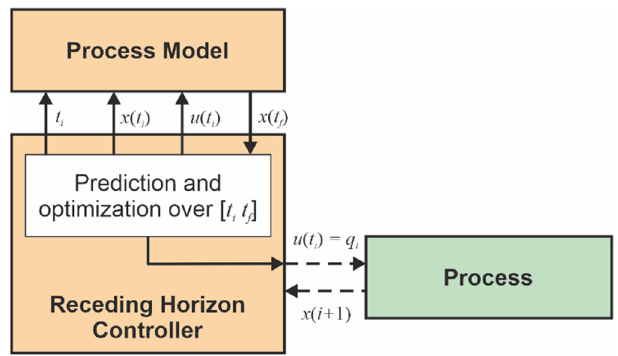
Figure 2. Closed loop with Receding Horizon Control.